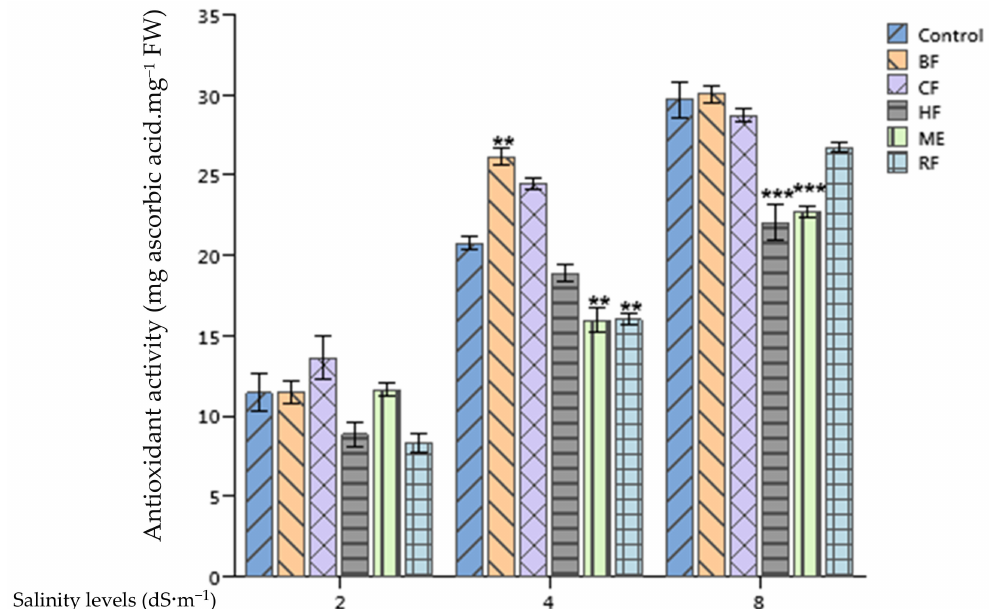
Figure 1. Effect of priming tomato seeds with Ulva lactuca methanol extract (ME), hexane fraction (HF), chloroform fraction (CF), n-butanol fraction (BF), and residual fraction (RF) under different salinity levels (2, 4, 8 dS · m − 1 ) on the antioxidant activity of tomato leaves. Mean ± Standard deviation (SD) values followed by asterisks indicate significant differences between treatments and the control (** p < 0.01; *** p < 0.001).